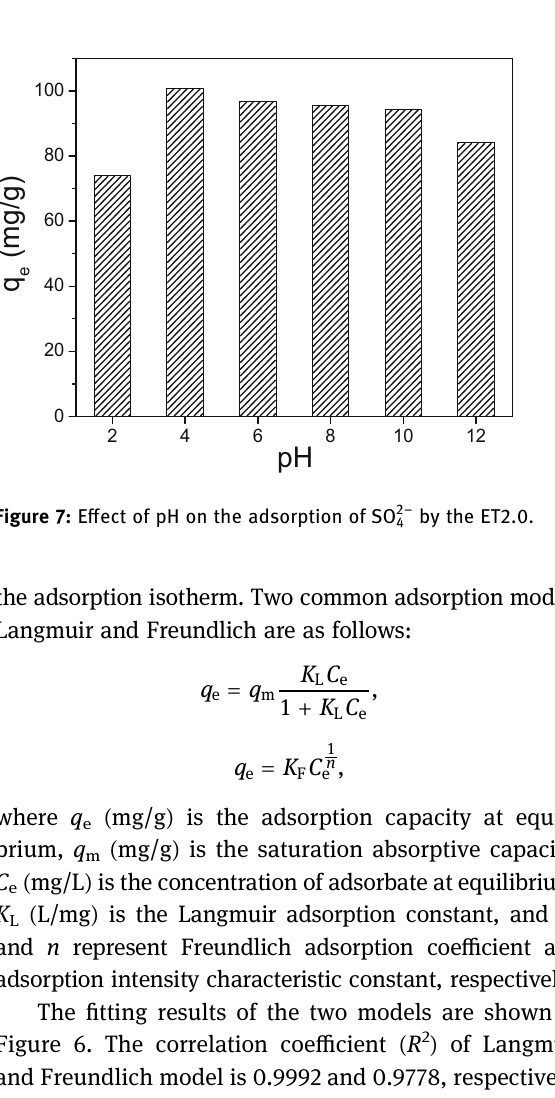
Figure 6. The correlation coe ffi cient ( R 2 ) of Langmuir and Freundlich model is 0.9992 and 0.9778, respectively.